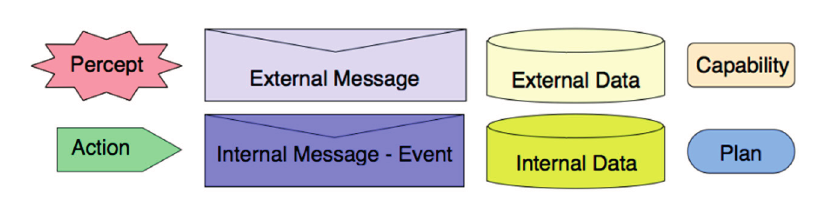
Figure 6. Notes used in agent and capability overview